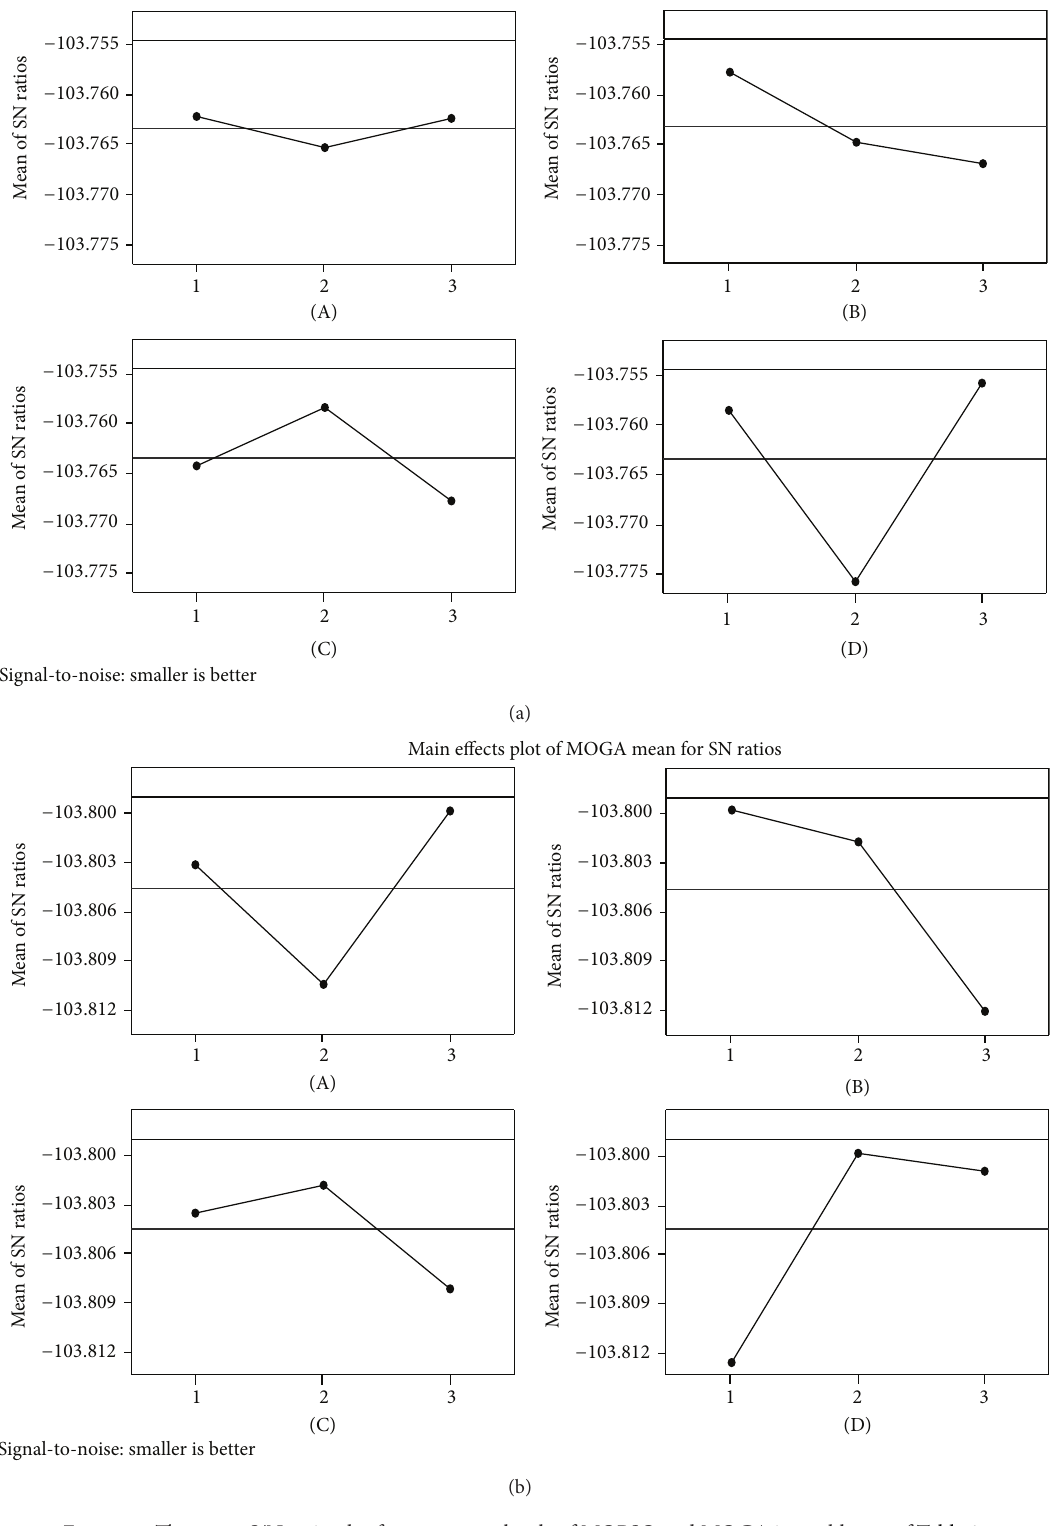
Figure 5: The mean S/N ratio plot for parameter levels of MOPSO and MOGA in problem 7 of Table